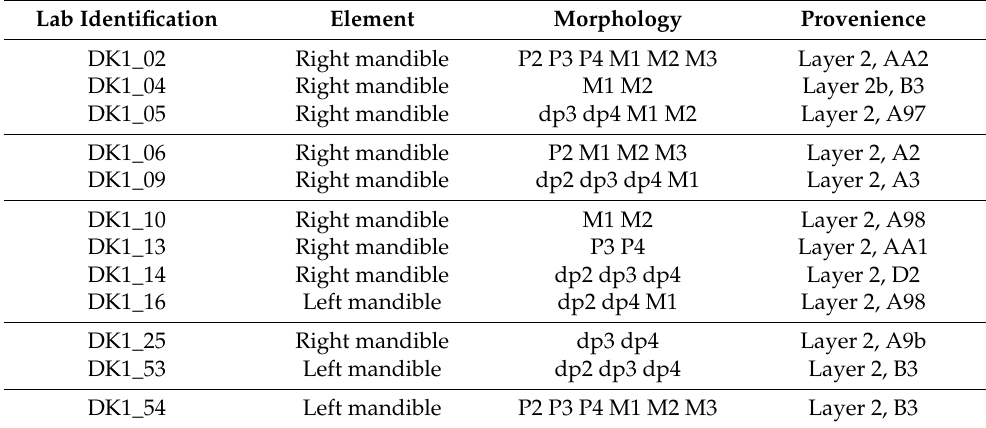
Table 1. Archaeological specimens from Die Kelders